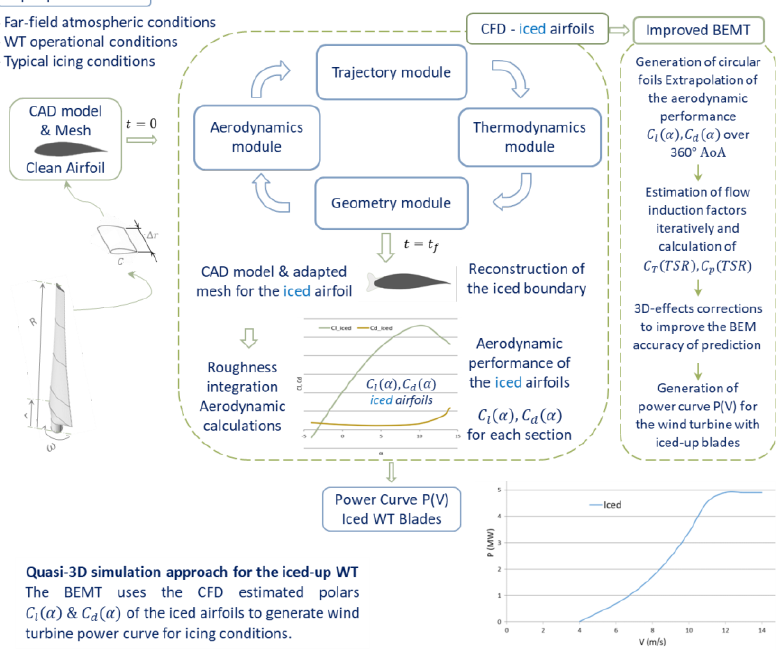
Figure 8. Generation of power curve P(V) for the wind turbine with iced-up blades. @Fahed Martini.